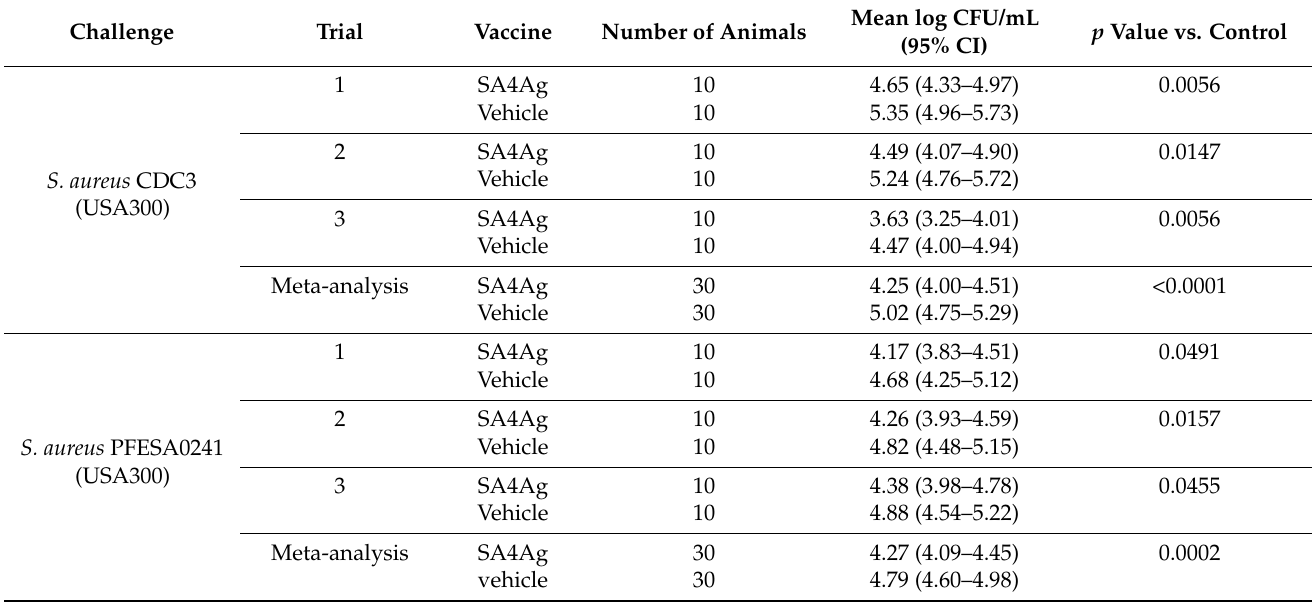
Table 3. Immunization with SA4Ag Reduces Bacterial Burden in a S. aureus Bacteremia